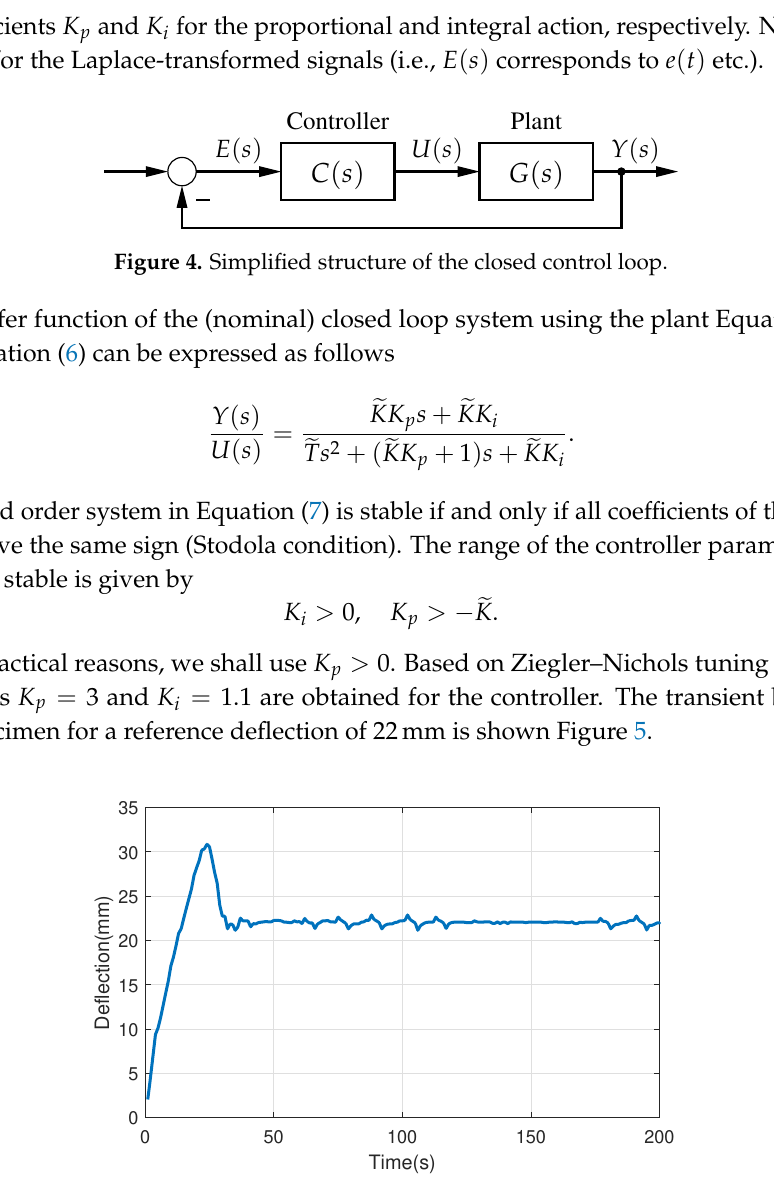
Figure 5. Deflection of the controlled system for 22mm reference with classically designed proportional integral (PI)